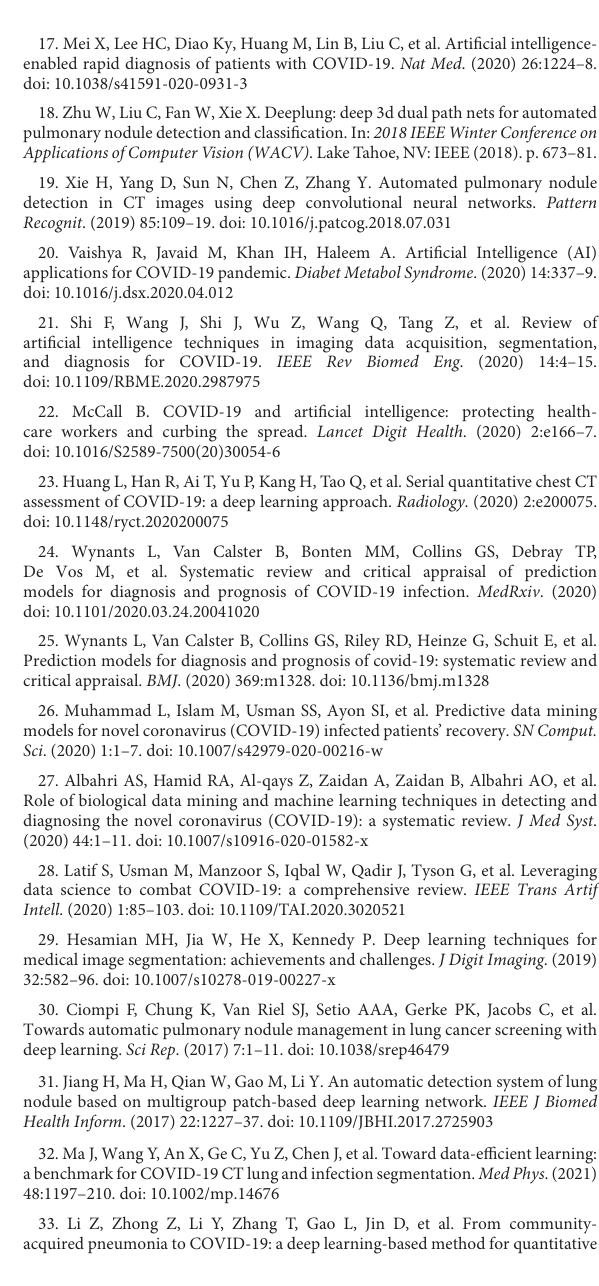
SUPPLEMENTARYFIGURE5 Number of normal and infected slices of the data used in the test set. SUPPLEMENTARYFIGURE6 Slice infection percentage in the test sets. SUPPLEMENTARYFIGURE7 Sample count of different classes of infection severity in External Test sets 1 and